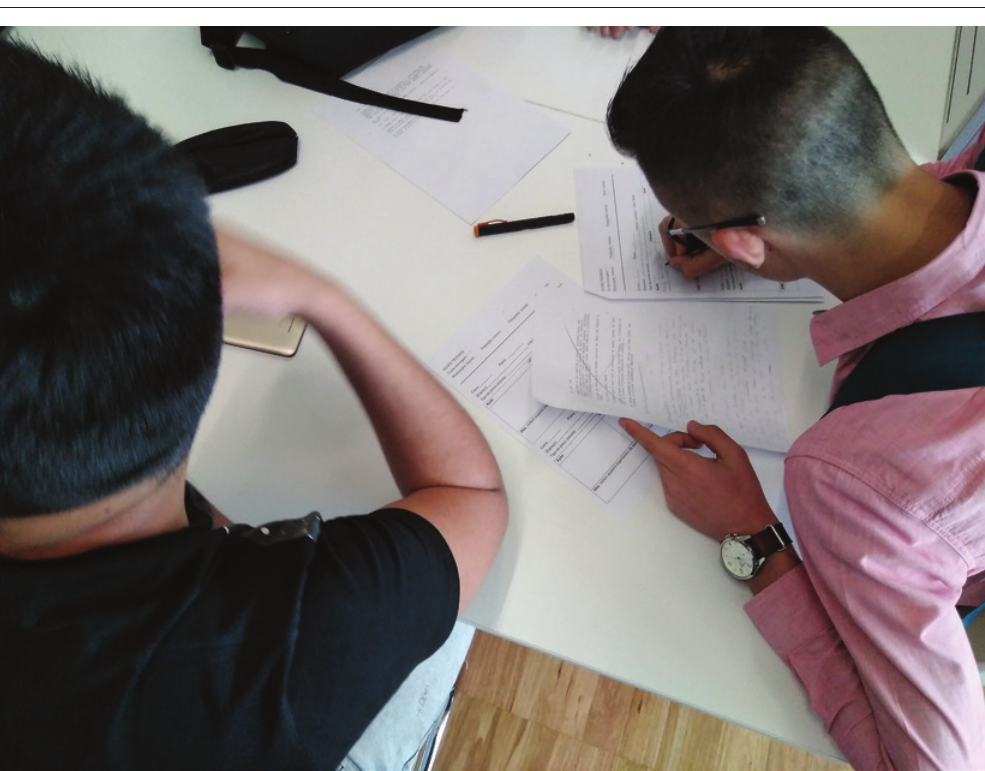
figure 3: Students working on pre-production of their short